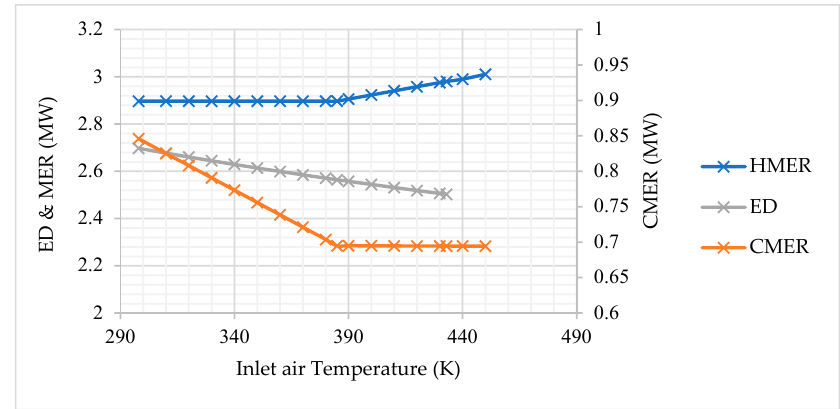
Figure 15. The hot minimal energy required (HMER), cold minimal energy required (CMER), and total exergy destruction (ED) of case 2 with respect to the combustion air intake temperature.